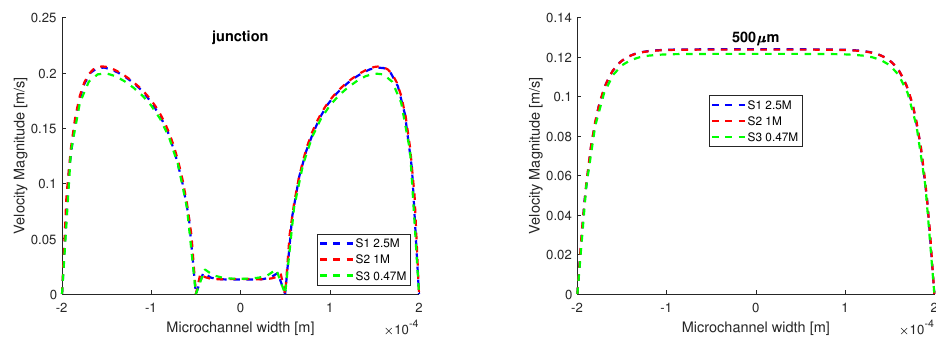
Figure 2. Grid test using homogeneous flow. The test fluid is water and the input velocities are: v 1 = v 3 = 0.1 m/s and v 2 = 0.006 m/s. There are minor differences between the results obtained from S1 and